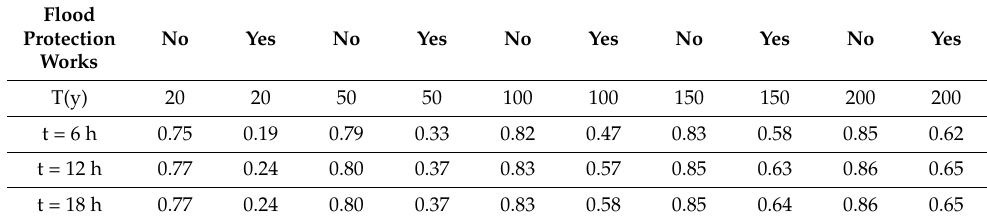
Table 6. Average hazard on Koropouli Street.